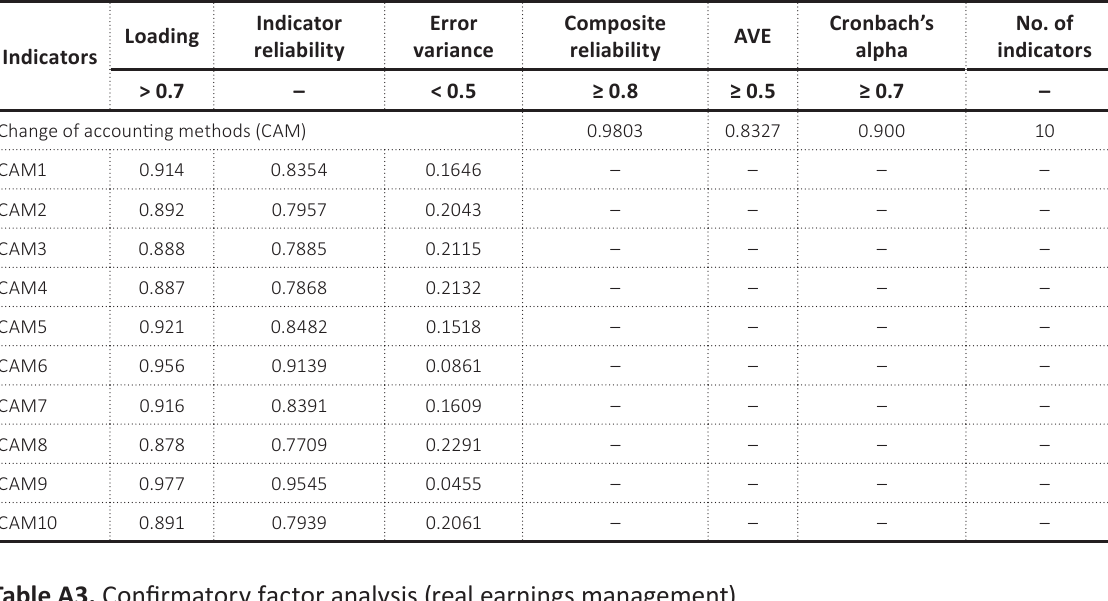
Table A3. Confirmatory factor analysis (real earnings management)